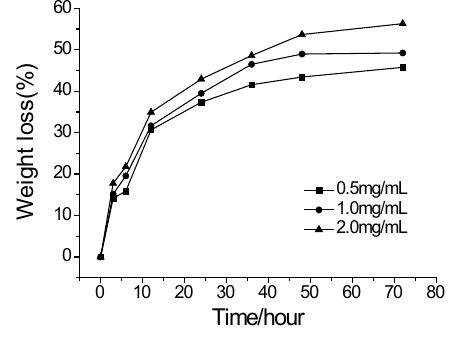
Figure 10. Degradation behavior as a function of time for sample 9 P(NIPAAm-co-Am) hydrogel with different pepsin concentrations in SGF solution at linker. The effect of the cross-linker content and enzyme